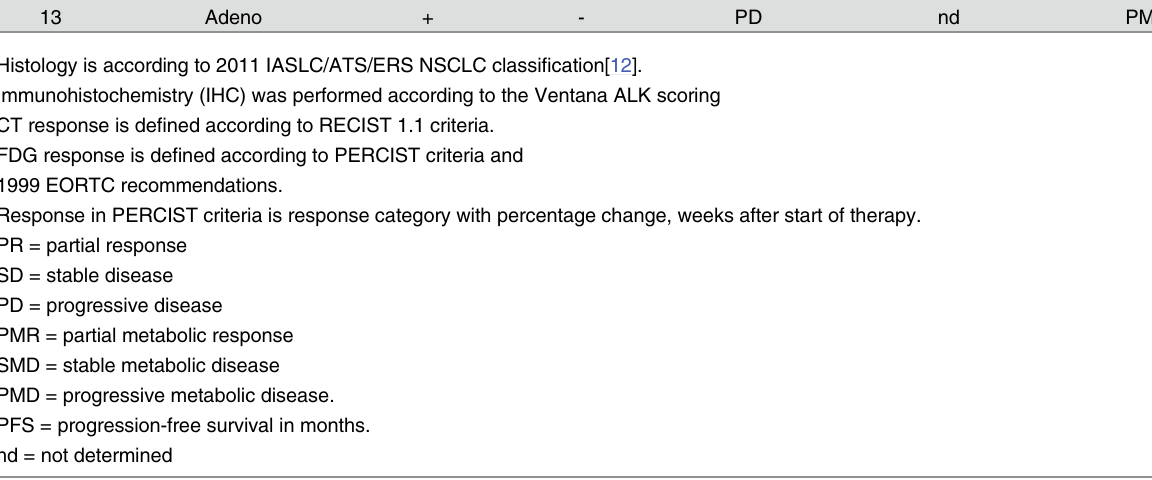
Baseline and 6 weeks CT and 18 F-FDG PET/CT measured responses In 13 patients PET/CT was performed during crizotinib treatment. With CT according to RECIST criteria, there were 9 patients with a partial response, 1 with stable disease and 3 patients had progressive disease after 6 weeks of therapy. Median PFS was 6.9 (range 0.9 – 26.1) months. With PET measurements according to 1999 EORTC recommendations, there were 10 par- tial metabolic responders, 1 stabile metabolic disease and 2 progressive metabolic disease. Using the PERCIST criteria in 10 patients, 8 had a partial metabolic response, 1 stabile meta- bolic disease and 1 progressive metabolic disease (Table 2). There were 2 discordant responses between PET and CT, with a more favorable response on PET (i.e. PMR with SD, or SMD with was more pronounced than measured PD). The per patient change in percentage of SUV max (Fig 1). Although the average outcome using the EORTC recommendations or with SUV peak PERCIST criteria were not impressive, all 10 patients had a clinically dramatic response on the 6 week PET/CT with visual assessment (Fig 2).